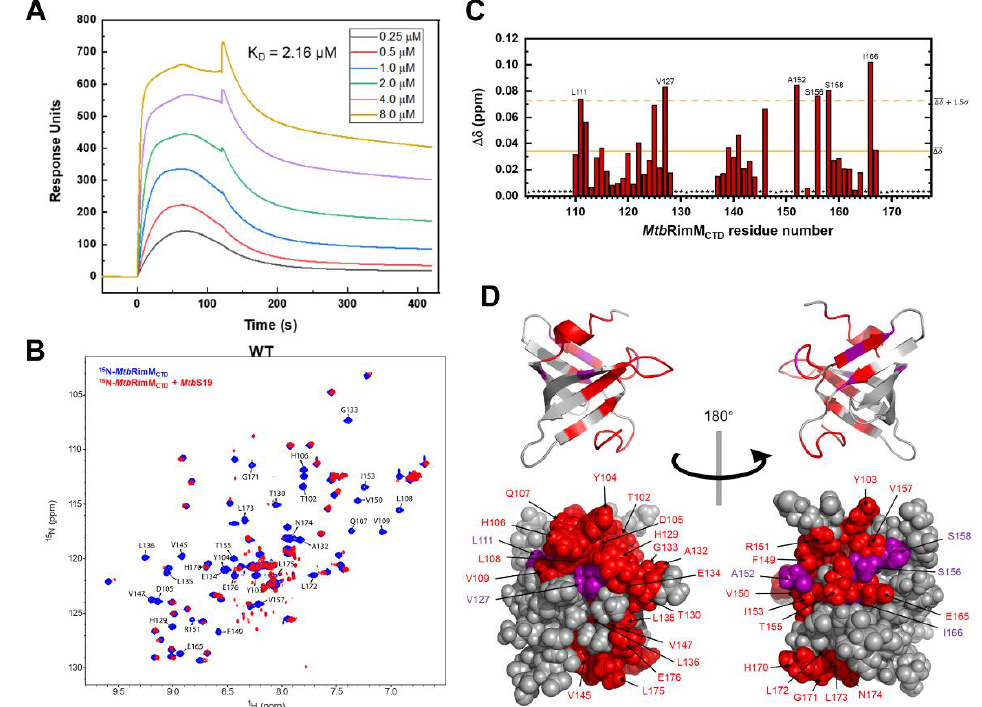
Figure 7. Interaction between Mtb RimM CTD and Mtb S19. ( A ) Surface plasmon resonance (SPR) affinity assay of Mtb RimM CTD binding S19 at serial concentrations. Blank control had been deducted from the serial data. ( B ) Overlapped 1 H- 15 N heteronuclear singular quantum correlation (HSQC) spectra of 15 N-labeled Mtb RimM CTD alone (blue) and in presence of equimolar Mtb S19 (red) for NMR titration assay. Peaks experiencing broadening-induced disappearance are indicated. ( C ) Plot of chemical shift perturbations (CSPs, ∆ δ ) of backbone amide groups. The mean value is indicated by a solid line, and the mean value plus 1.5 standard deviations by a dashed line. Asterisks indicate residues with disappear peaks at the titration destination, while triangles denote residues with invisible resonances before the titration, including D101, A131, and three prolines (residues 148, 168, and 169). ( D ) Mapping the binding surface to the 3D structure of Mtb RimM CTD . Disappeared peaks are colored in red, and peaks with large CSPs (above the dashed line in ( C )) in purple. Upper and lower panels are cartoon and sphere depictions of the structure, respectively.